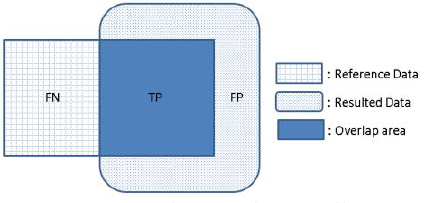
Figure 6. Definition of three different polygon cases